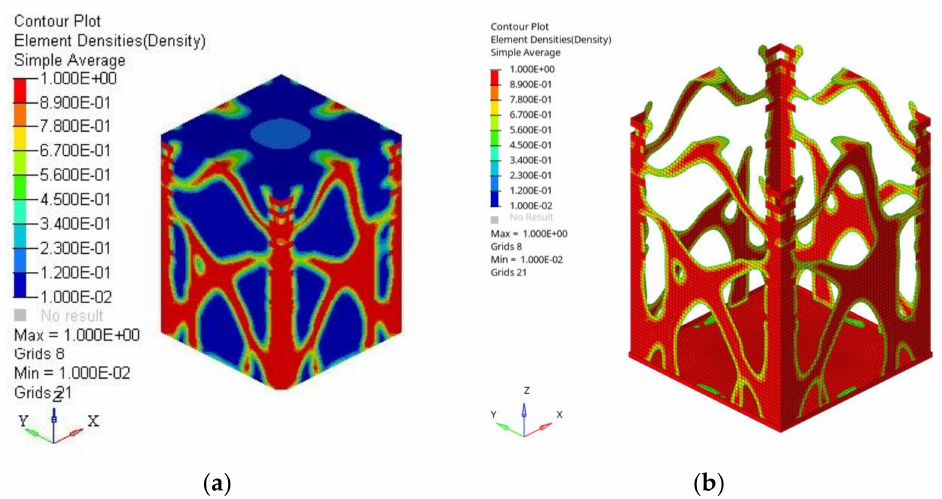
Figure 5. ( a ) Contour plot of topological optimization: the red elements form the optimized structure output (normalized material density ρ i = 1), the blue elements (normalized material density ρ i = 0) are negligible; hence not part of the final optimized structure. ( b ) final mesh obtained after the optimization